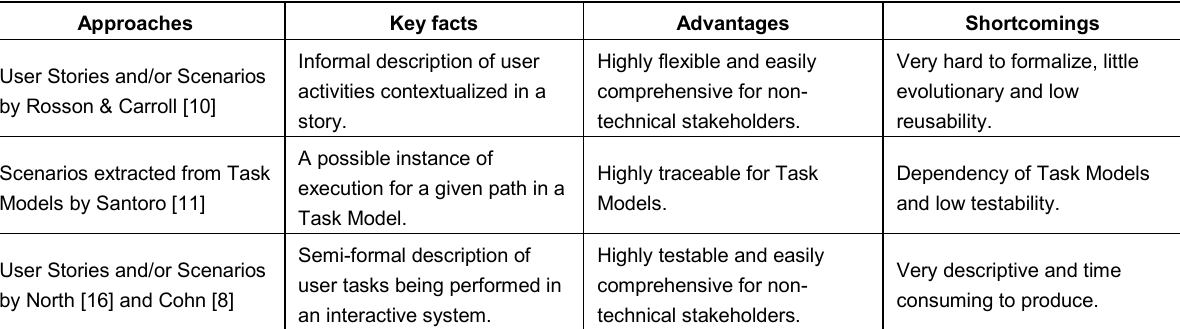
Table 2. Approaches for describing User Stories and